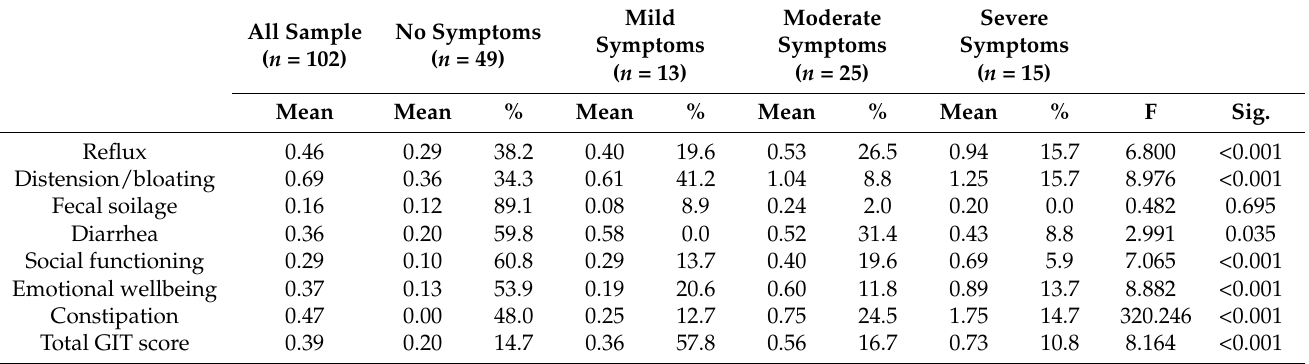
Table 4. Means of UCLA GIT 2.0 for different GI severity